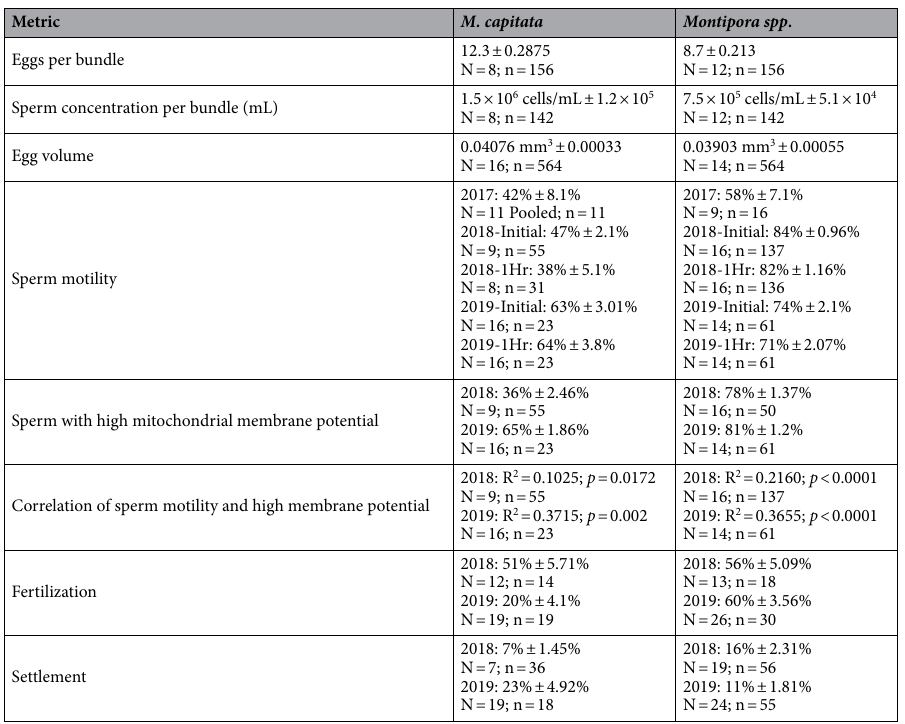
Table 1. Summary of reproductive data. Reproductive metrics assessed for Montipora capitata and Montipora spp . in 2018 and 2019 with mean and SEM. Number of unique genotypes (N), unique crosses (N), and sample replicates (n) used per analysis and year are given. Unique crosses are genotype combinations used for fertilization and settlement only. The coefficient of determination (R 2 ) is given for the proportion of variance in percent sperm motility explained by the variation in percent of sperm with high mitochondrial membrane